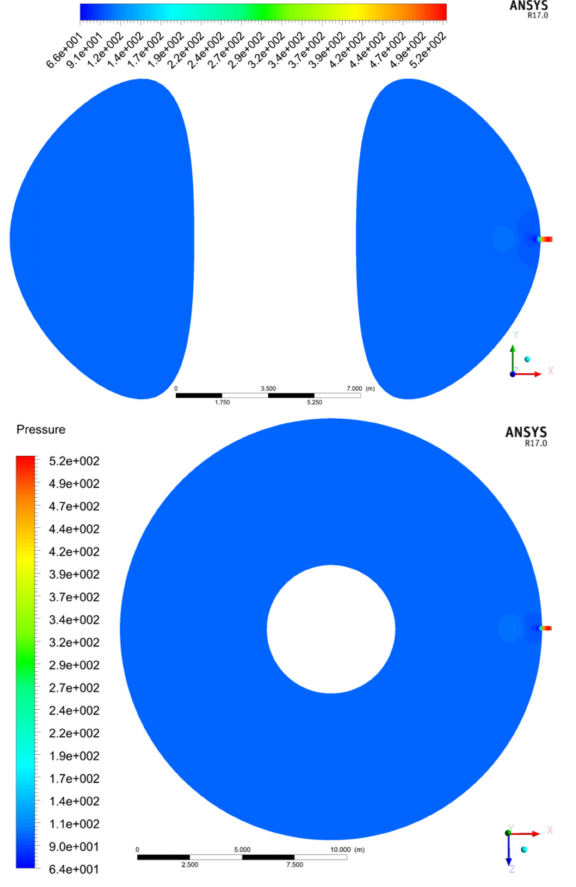
Figure 4. Static pressure on the xy plane ( top ) and xz plane ( bottom ) at 1 × 10 − 2